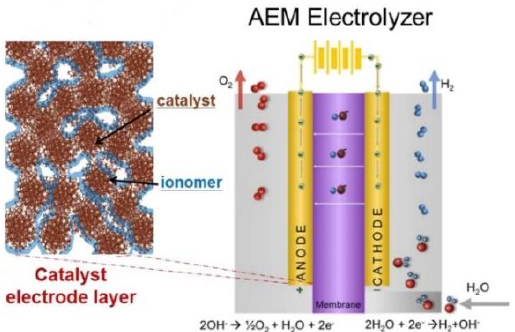
Figure 1. Catalyst electrode layer and membrane electrode assembly for anion exchange membrane (AEM) electrolyzer, where the catalyst is mixed with an ionomer, Reprinted from Artyushkova et al., License Number 4406040674790 [14].